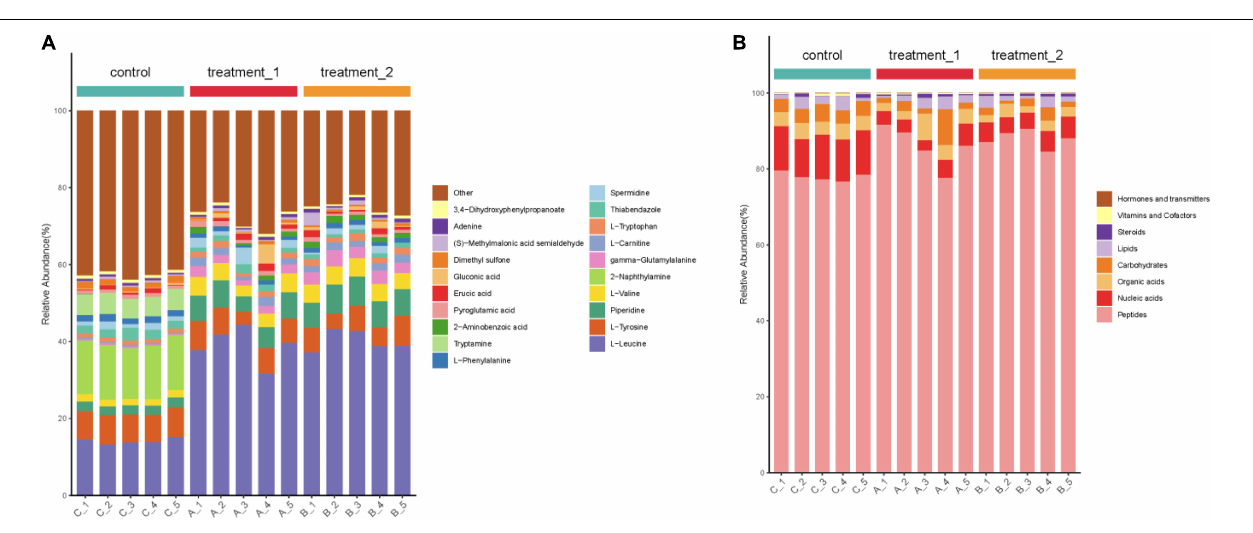
FIGURE 7 | (A) Stacked column chart indicating relative abundance of metabolites or (B) groups of metabolites. Shown in the left panel is the percentage accumulation of the top 20 metabolites upon treatment with OFL at two different concentrations compared with the control treatment. The right panel shows the relative abundance of metabolites according to biological roles. The concentration of 10 mg/L OFL is treatment 1; and the concentration of 5 mg/L OFL is treatment 2; Control does not add